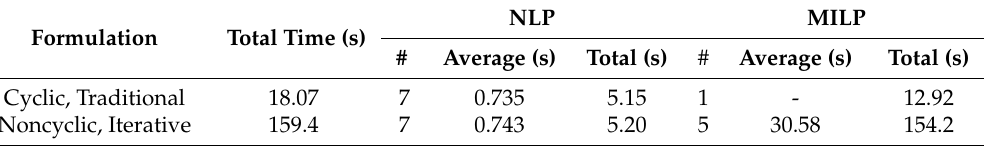
Table 12. Computational results: Scenario 1.